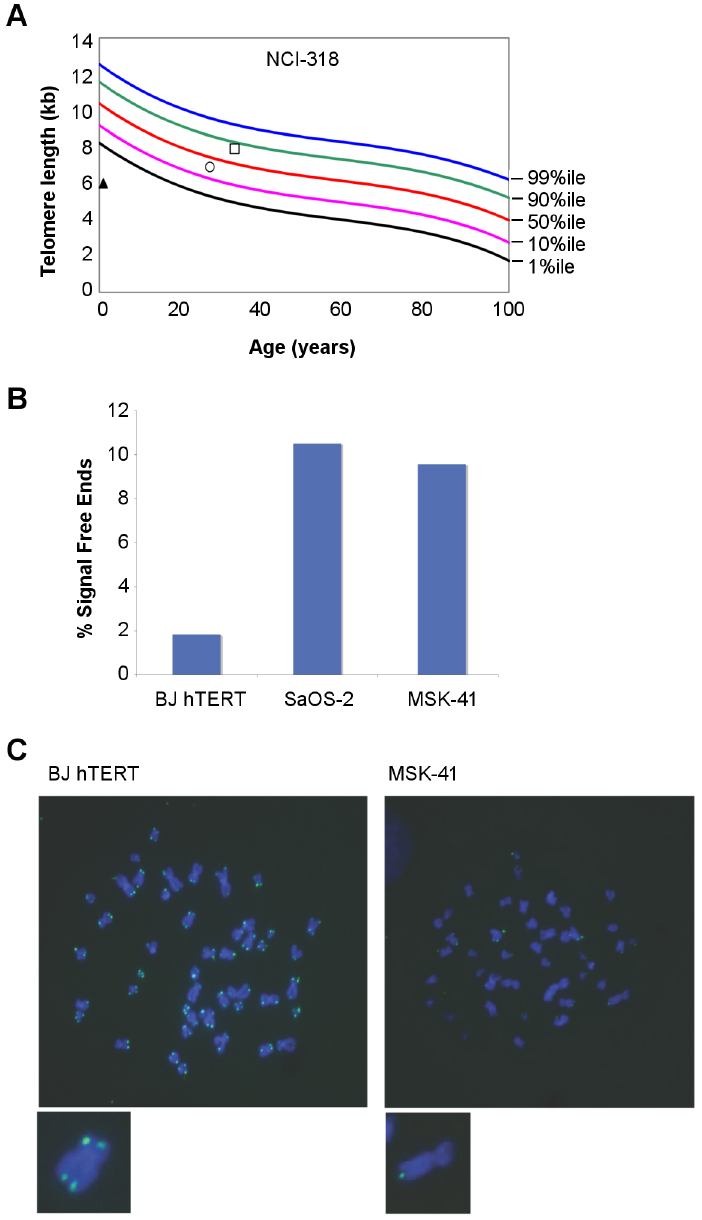
Figure 2. Telomere length is altered in individuals with RTEL1 R1264H . (A) Primary lymphocyte telomeres in family NCI-318 were measured by flow cytometry with fluorescent in situ hybridization (FISH) [3]. The proband is indicated by a triangle, the mother by a circle, and the father by a square. (B) Telomere FISH analysis of MSK-41 hTERT-immortalized fibroblasts revealed extreme telomere length heterogeneity. Quantitation of chromatids lacking detectable telomeric signal is shown. BJ hTERT, a normal hTERT-immortalized fibroblast line, and SaOS-2, an osteosarcoma cell line that relies on recombination-based telomere maintenance (ALT), are presented for comparison. (C) Representative metaphase spreads of MSK-41 and BJ hTERT are